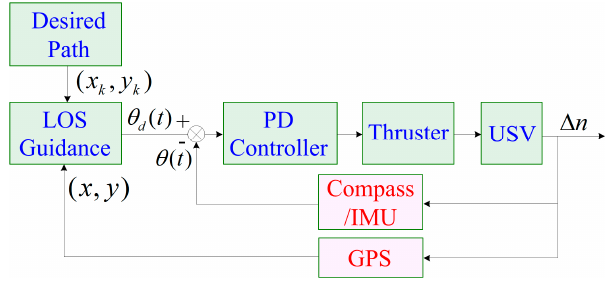
Figure 13. The USV motion control system.